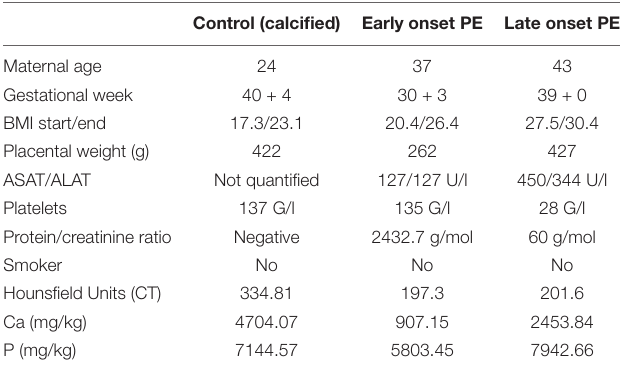
TABLE 2 | Characteristics of the three representative placentas selected for the multiscale imaging of calcific